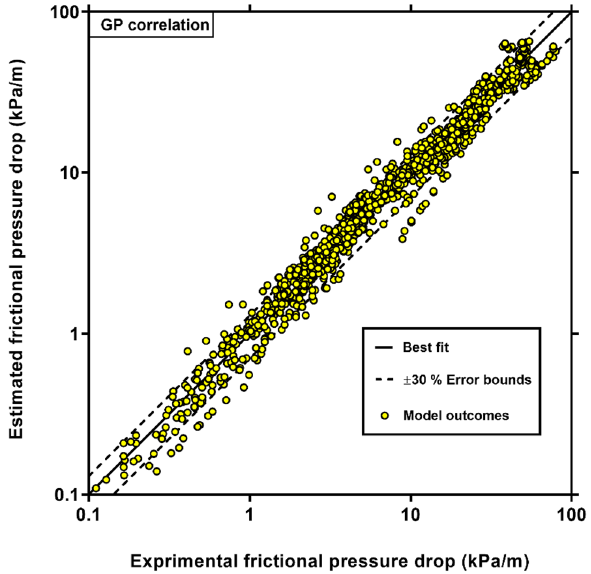
Figure 7. Comparison of the experimental FPD data with those estimated by GP model (Eq. (20)).